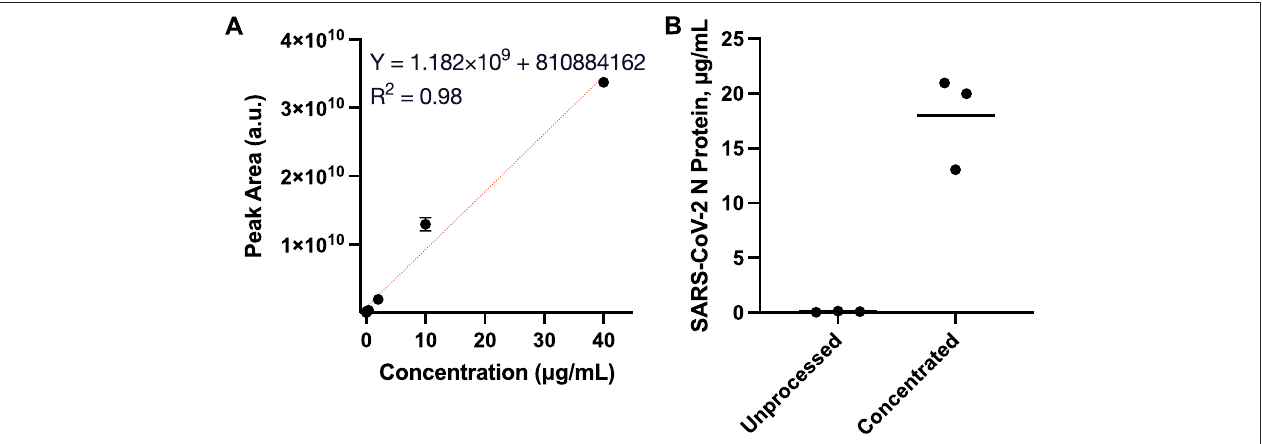
FIGURE 4 | Mass spectrometry analysis for quantitating SARS-CoV-2 N protein concentration by measuring the area under the ionization intensity vs. retention time peaks of the peptide sequence R.ITFGGPSDSTGSNQNGER.S [15, 32]. (A) Calibration using standards, 0, 0.08, 0.4, 2, 10 and 40 μ g/ml SARS-CoV-2 N protein; (B) Specimens ’ SARS-CoV-2 N protein concentrations before and after the osmosis. The solution average concentration was 0.09 ± 0.06 μ g/ml prior to the process. Then, the concentration increased to 18.0 ± 4.3 μ g/ml N protein, nearly 200-fold, after the enrichment.